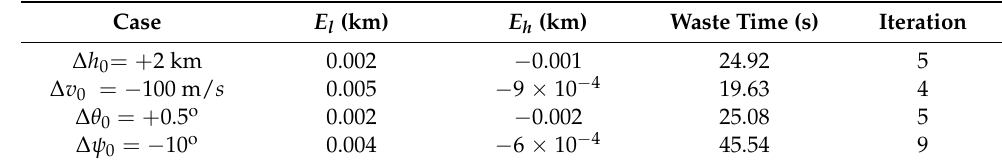
Table 3. Generation effect with disturbance of the initial